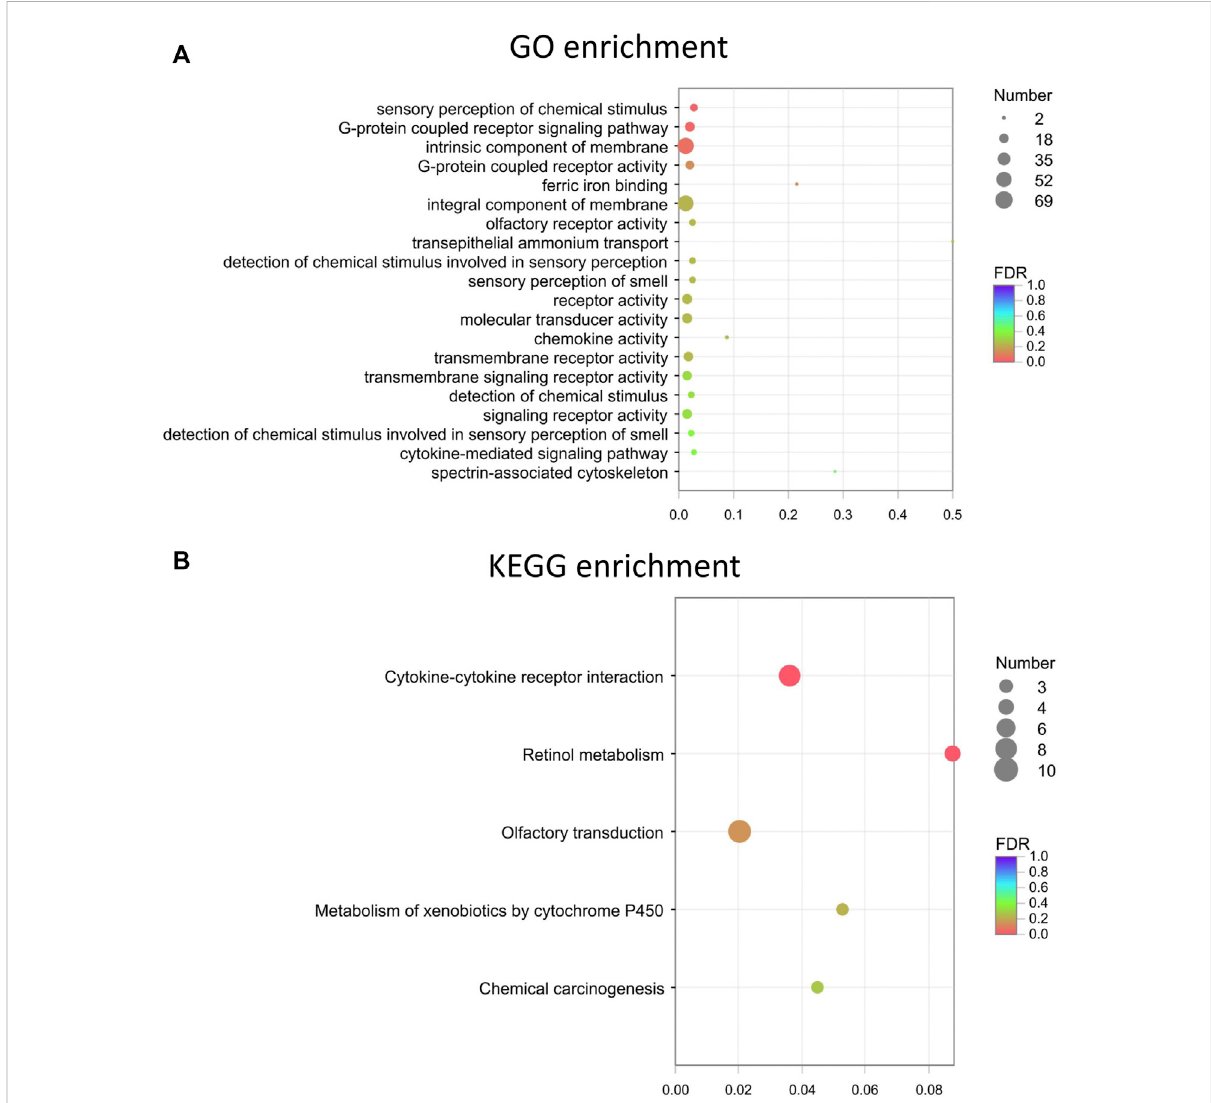
FIGURE 5 Thetop20GOandKEGGenrichmentofthemRNAs. (A) Top20GOtermsforthedifferentiallyexpressedmRNAs. (B) TopKEGGenrichmentfor the differentially expressed mRNAs. Dot color: towards blue, FDR towards 1.0; towards red, FDR toward 0.0. Dot size: the number of core genes within the